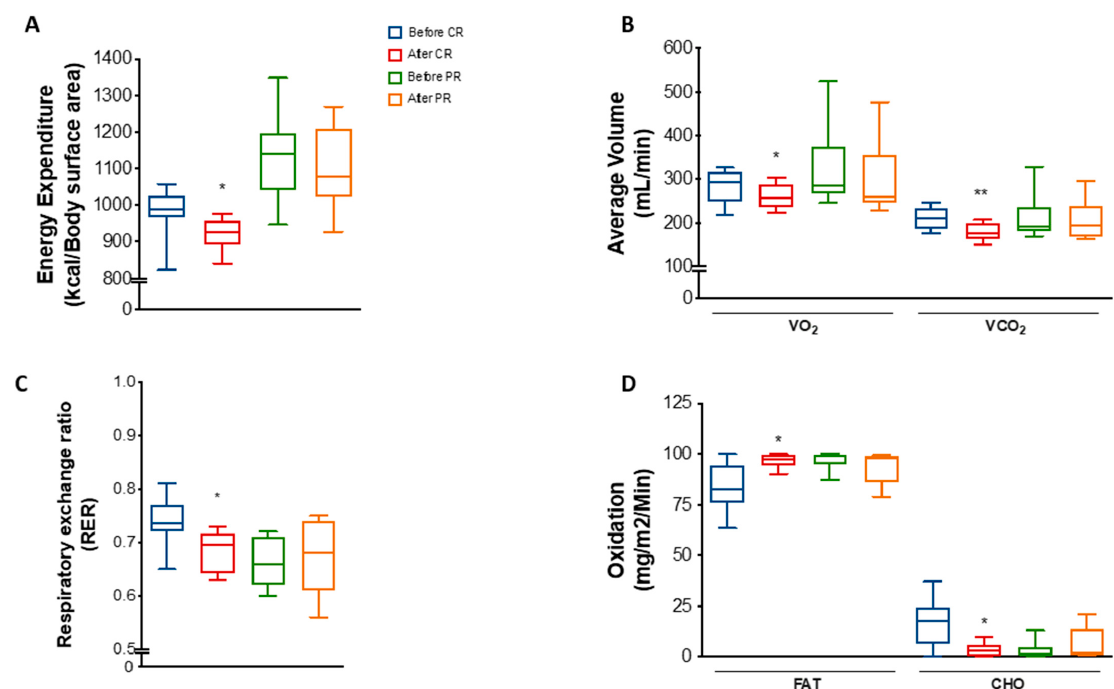
Figure 2. Energy expenditure and substrate utilization after caloric restriction (CR) or protein restriction (PR). Data obtained using indirect calorimetry. ( A ) Energy expenditure before and after CR (* p = 0.0311) and before and after PR ( ns p = 0.7568). ( B ) Average volume of VO 2 and VCO 2 before and after CR (* p = 0.0126 and ** p = 0.0051) and before and after PR ( ns p = 0.2736 and ns p = 0.5507). ( C ) RER (respiratory exchange ratio) before and after CR (* p = 0.0296) and before and after PR ( ns p = 0.8571). ( D ) Lipid (FAT) and carbohydrate (CHO) oxidation before and after CR (* p = 0.0454 and * p = 0.0452) and before and after PR ( p = 0.4281 and p = 0.4270). Data are shown in box plot format. ANOVA mixed-design analysis of variance was performed.